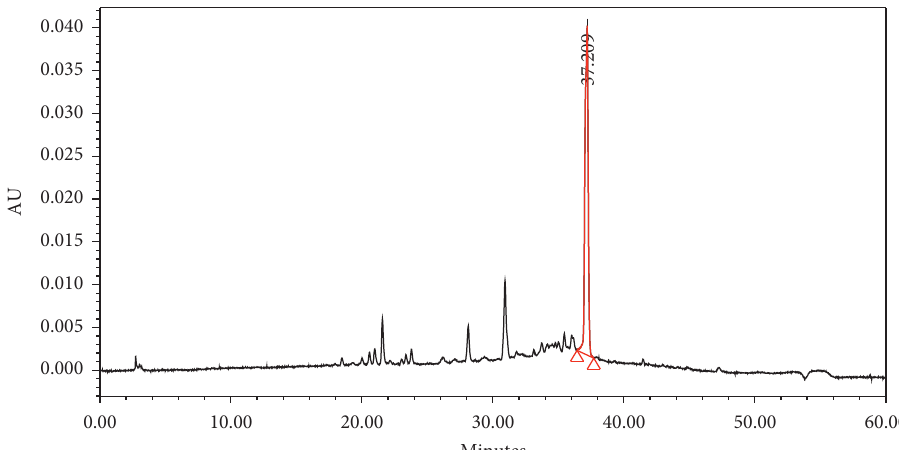
Figure 9: High performance liquid chromatography profile of the crude extract showing vitexin identified at 21.834 minutes (retention